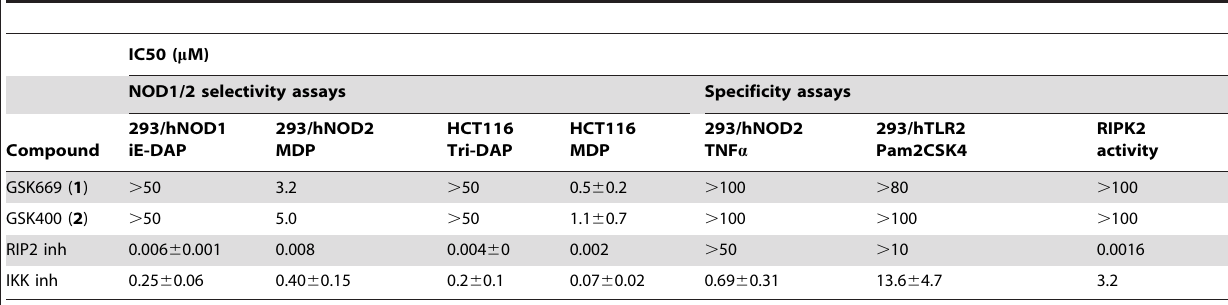
Table 1. Activity of NOD2 selective compounds and inhibitors of IKK and RIP2 in cell-based assays used for hit identification and triage.